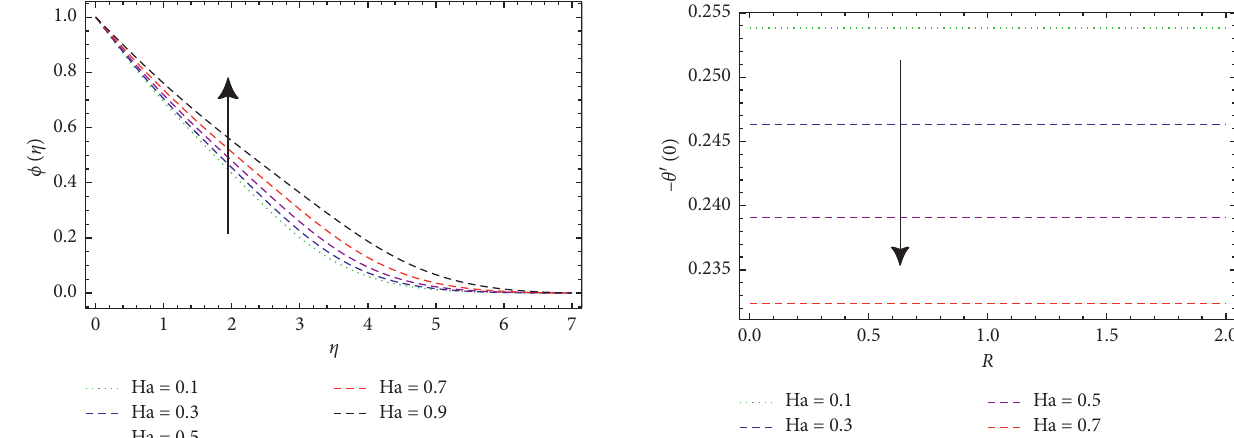
Figure 15: Influence of the ϕ ( η ) profile via Ha.